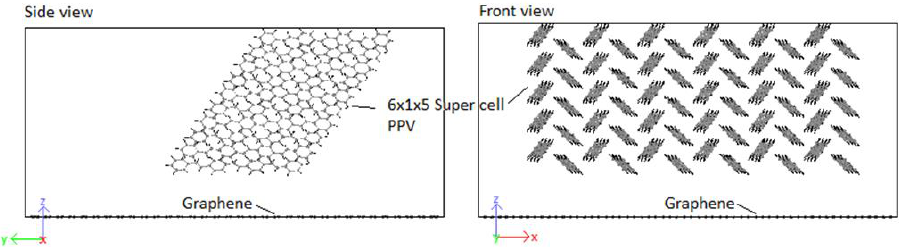
× 7 nm graphene interaction. Molecules 2020 , 25 , x FOR PEER REVIEW